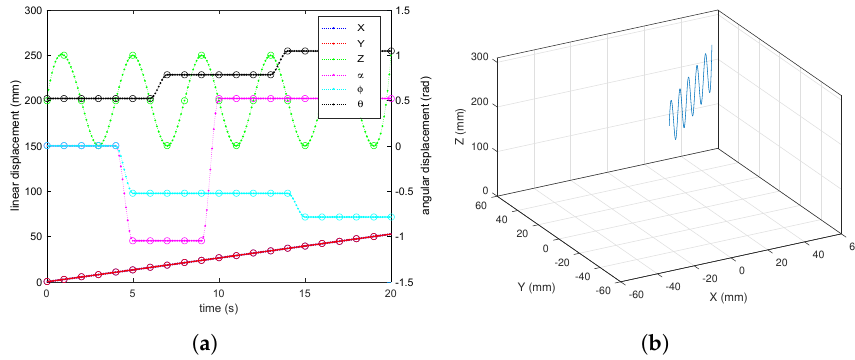
Figure 10. Oscillation trajectory: ( a ) trajectory distribution and ( b ) 3D representation.